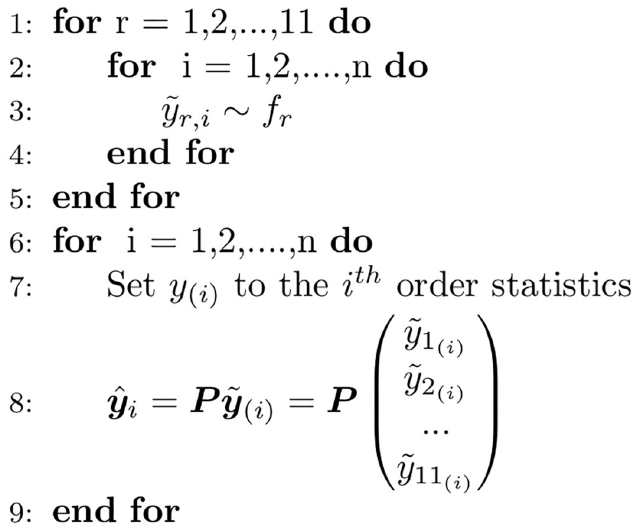
Fig 6. Ordered OLS sampling from probabilistically coherent joint distribution given a collection of marginal distributions. Note that the corresponding WOLS method is obtained by replacing P with P V .